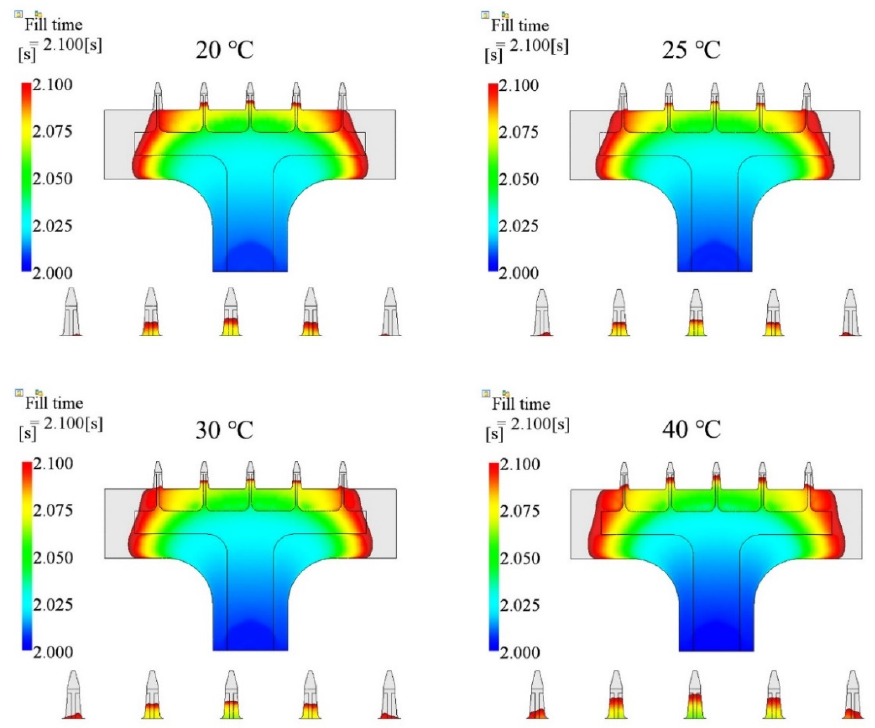
Figure 12. Filling contours using different mold temperatures at the same moment.